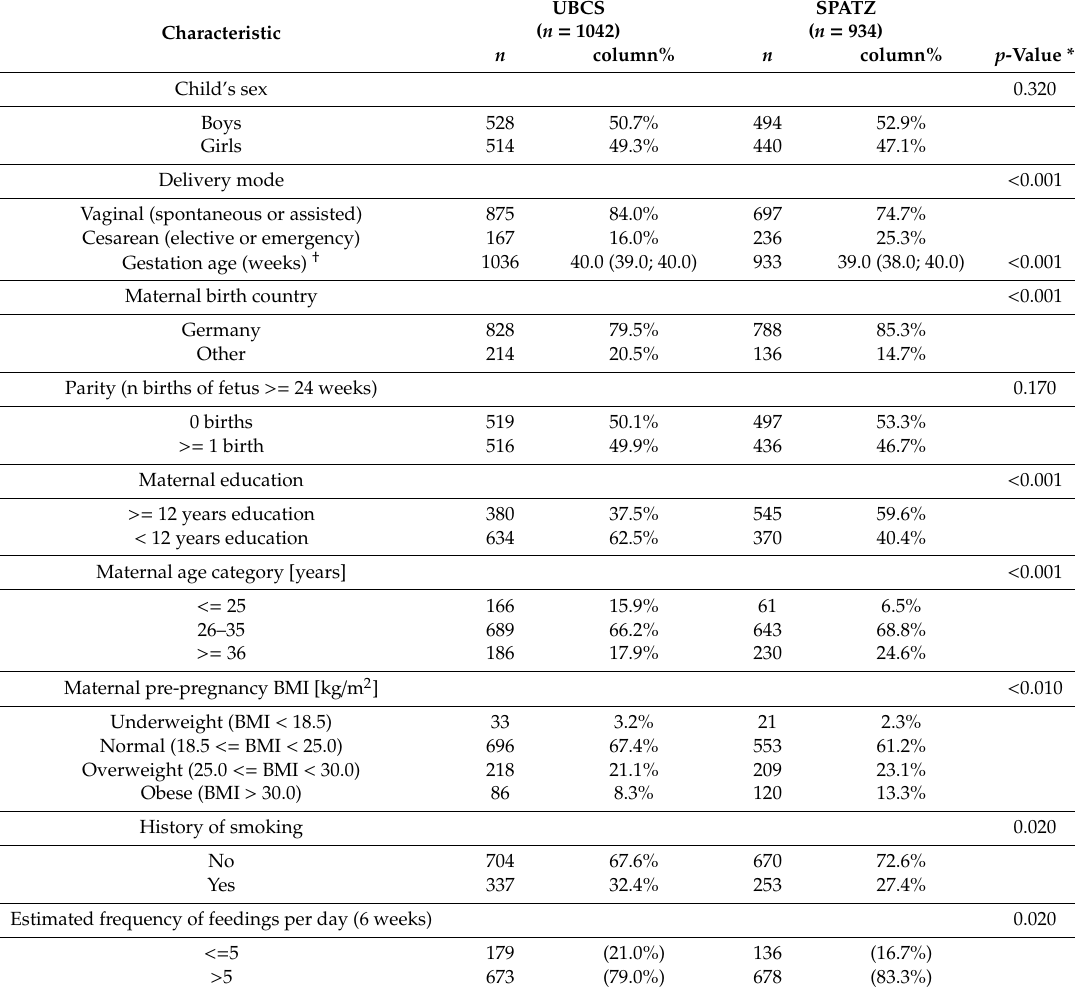
Table 1. Demographic characteristics of mothers of singleton births and their children in the Ulm